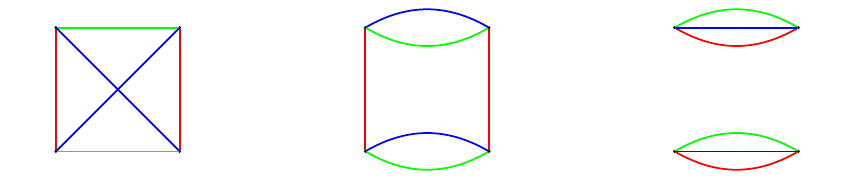
Figure 2 . Graphical representation of the quartic O ( N ) 3 invariants. From left to right: the tetrahedron, the pillow, and the double-trace (there are three pillow contractions, distinguished by the color of the vertical